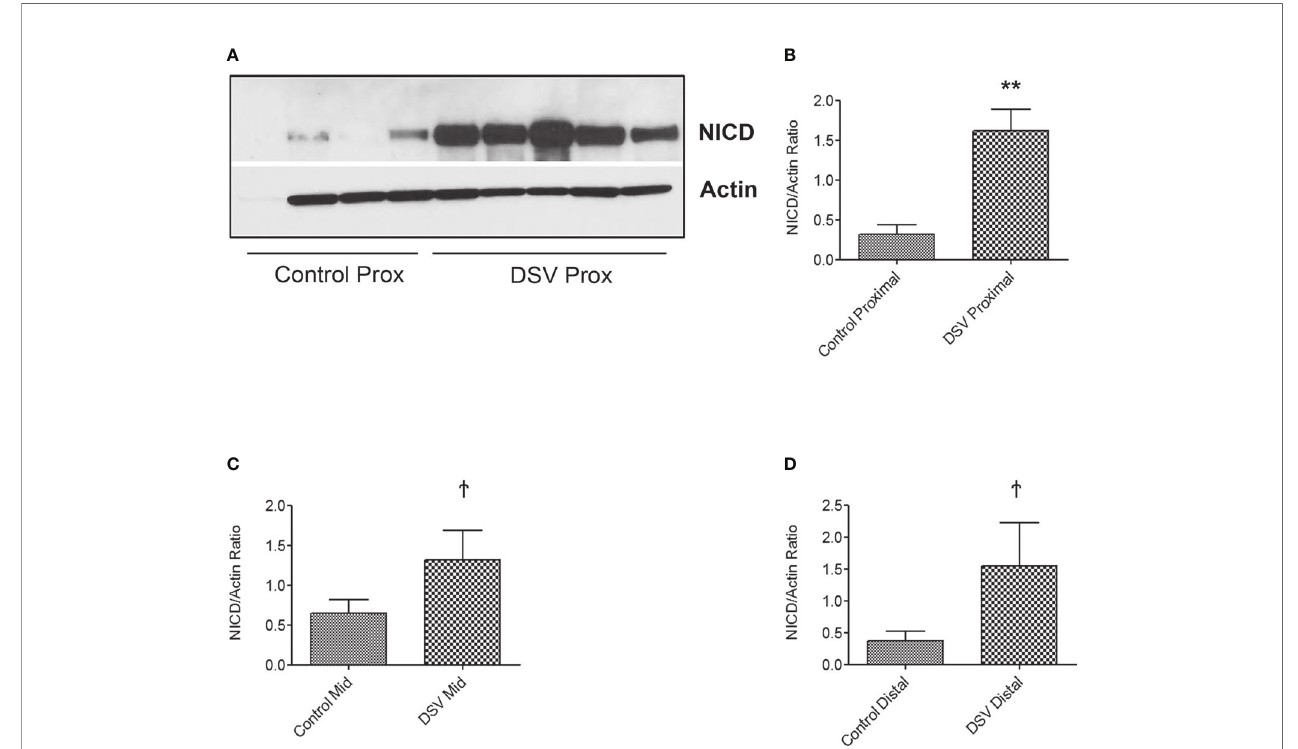
FIGURE 9 | DSV induces NICD activation in the mouse small intestine Mice were orally gavaged with either PBS or DSV (10 9 ). One hour later, mice were euthanized and 1/3 rd parts of small intestinal tissue corresponding to Prox (duodenum), Mid (Jejunum), and Distal (ileum) regions were collected in Trizol. Protein samples (10µg) were prepared and analyzed by Western blotting for NICD expression. Actin was used as a loading control. (A) NICD expression in protein samples from 4 control and 5 DSV-treated tissues (B – D) Quanti fi cation of Western blots. Blots were quanti fi ed with ImageJ by analyzing the ratio of NICD/Actin. Data represents Mean ± SEM. **p < 0.01, Ϯ p >